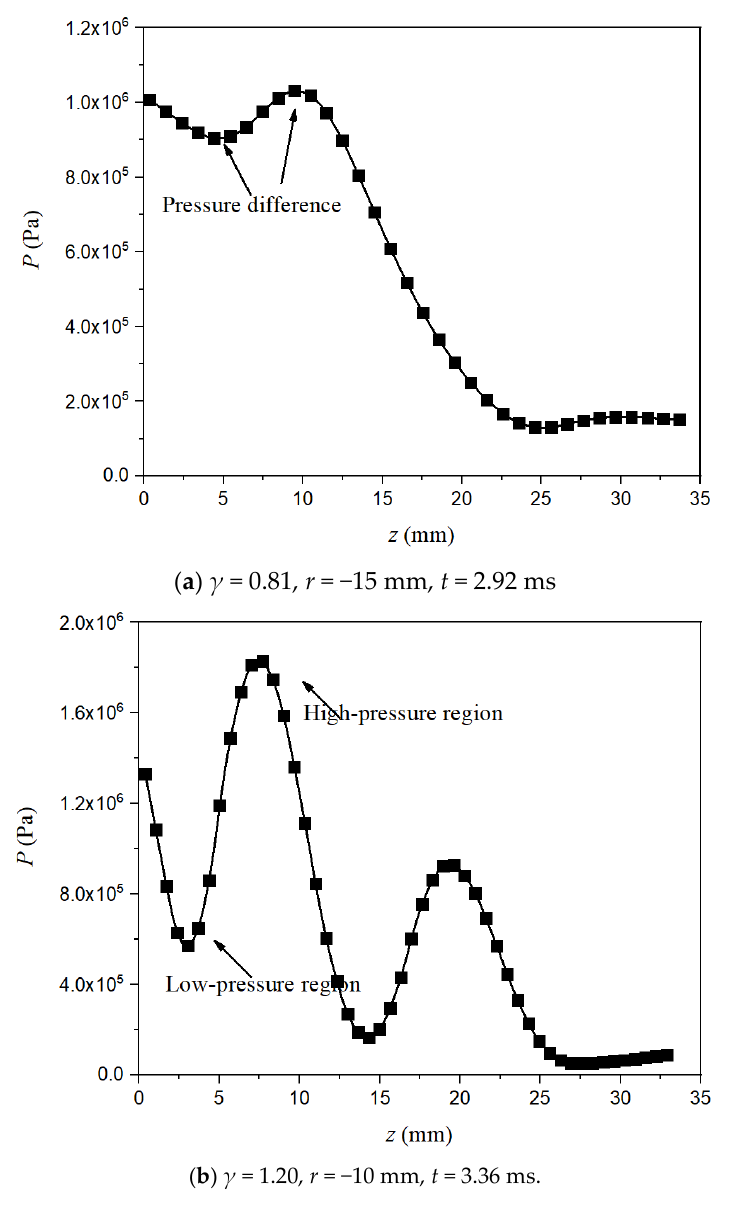
Figure 10. The comparisons of the measured high-pressure region for different conditions. The experimental value is obtained along the vertical axis, when γ = 0.81, r = − 15 mm and t = 2.92 ms for image ( a ); and γ = 1.20, r = − 10 mm and t = 3.36 ms for image ( b ).